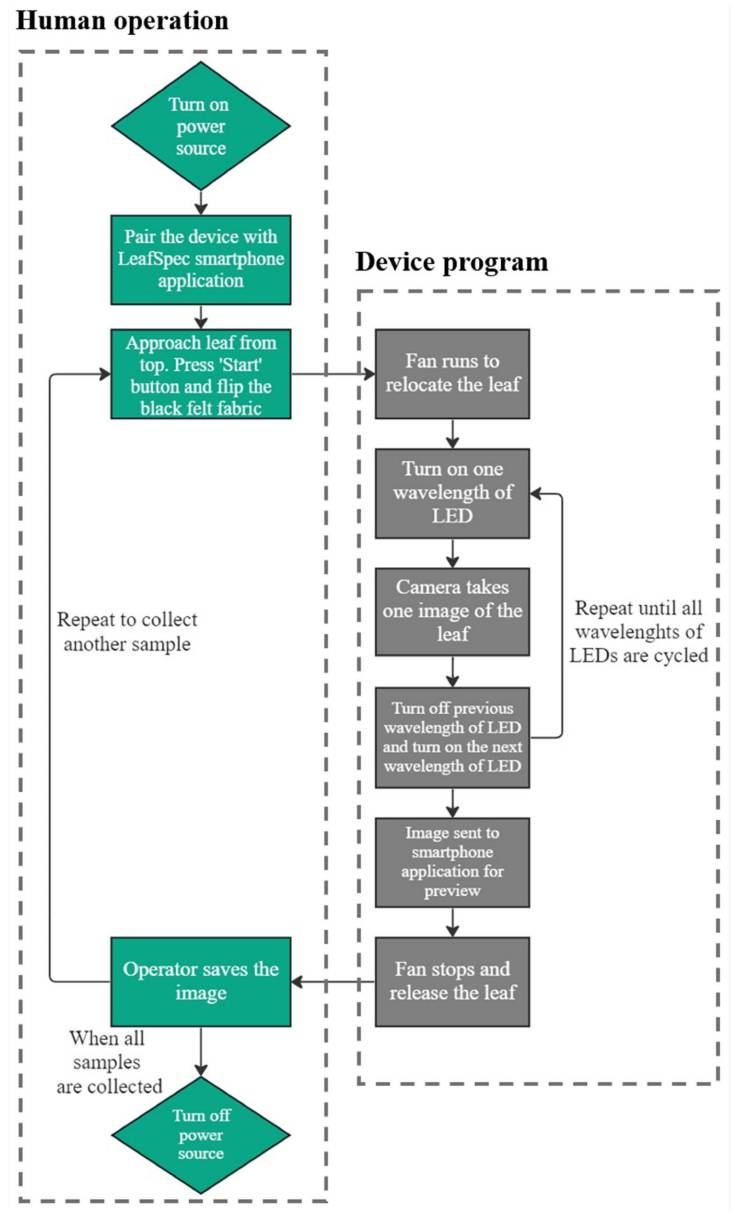
Figure 3. Operation